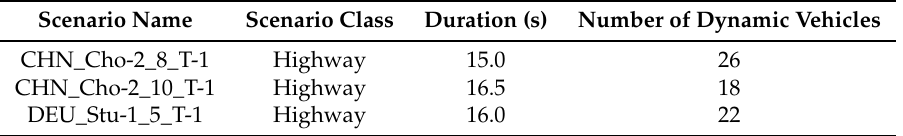
Table 2. CommonRoad dataset scenarios used to study the effect of latency in the positioning error.